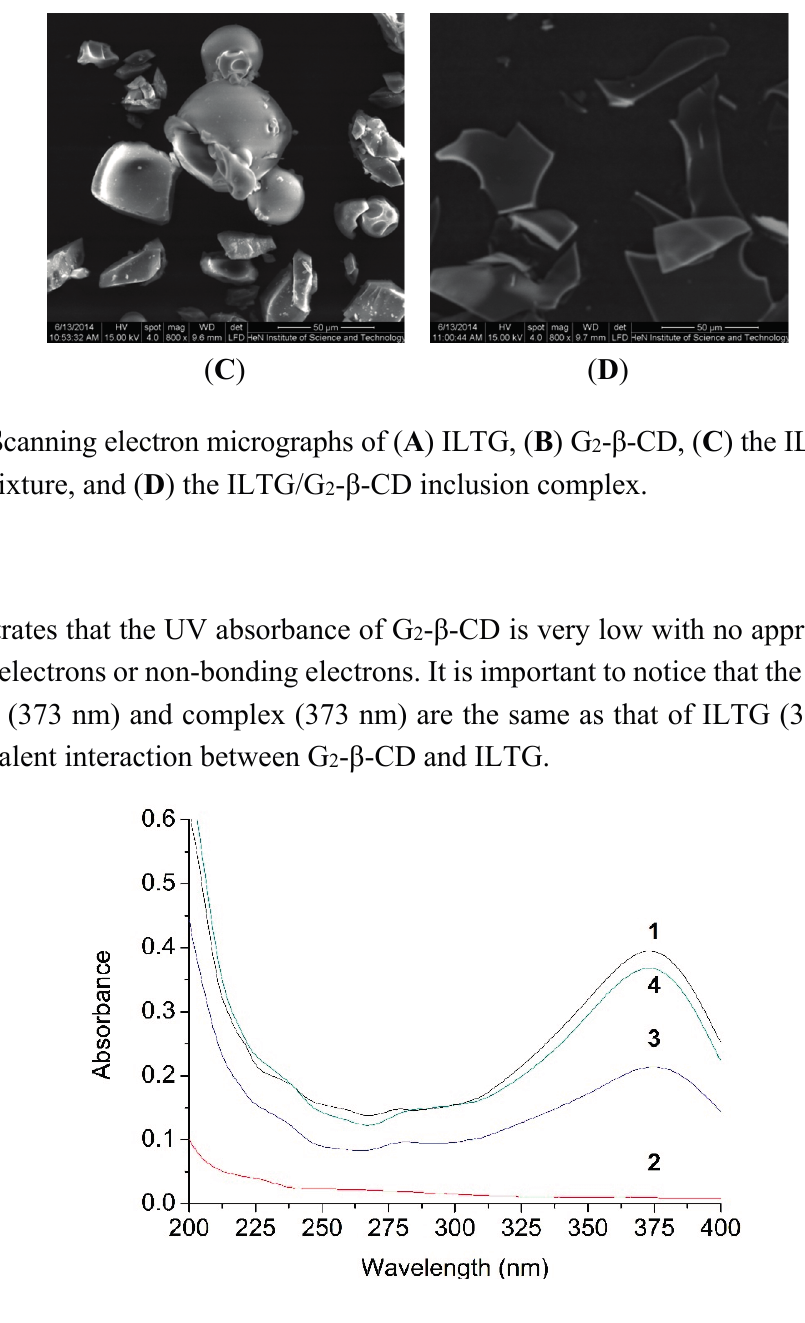
Figure 4. UV spectra of (1) ILTG (373 nm), (2) G2- β -CD, (3) the ILTG/G2- β -CD physical mixture (373 nm), and (4) the ILTG/G2- β -CD inclusion complex (373